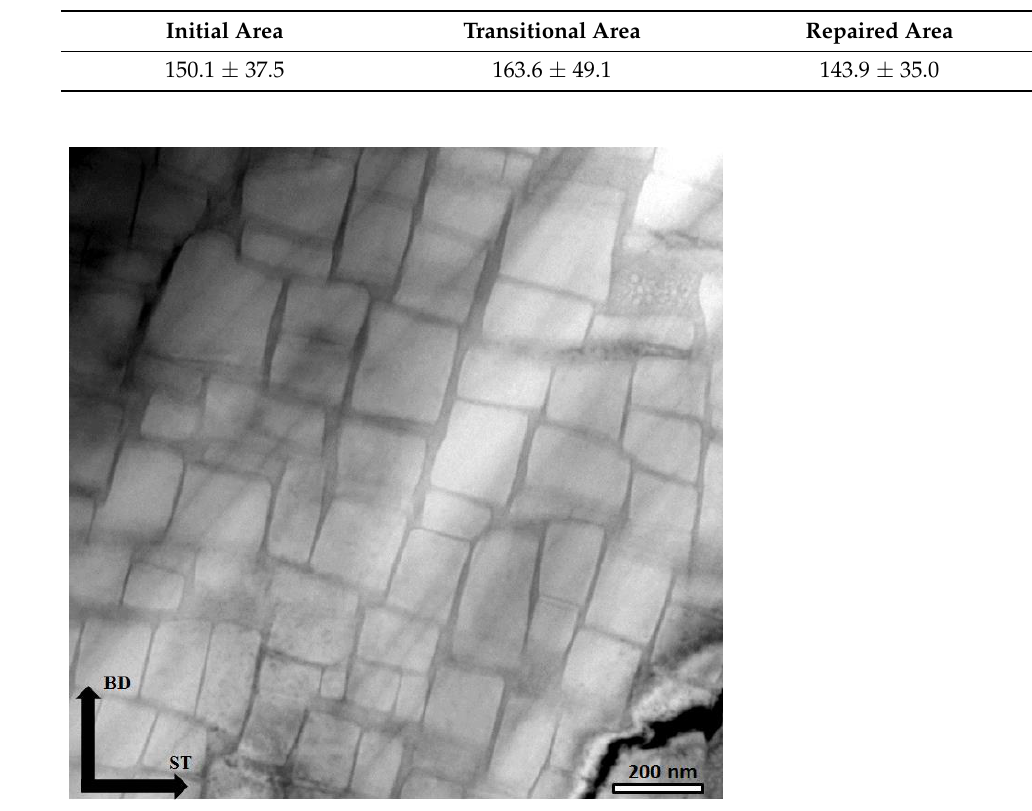
Table 3. The average size of γ (cid:48) -phase precipitations, nm.